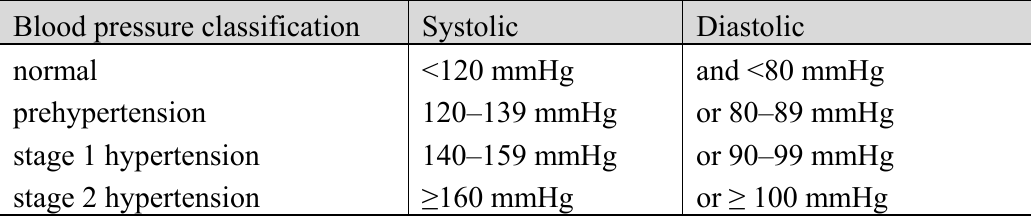
Table 1. Blood pressure classification in adults [3].